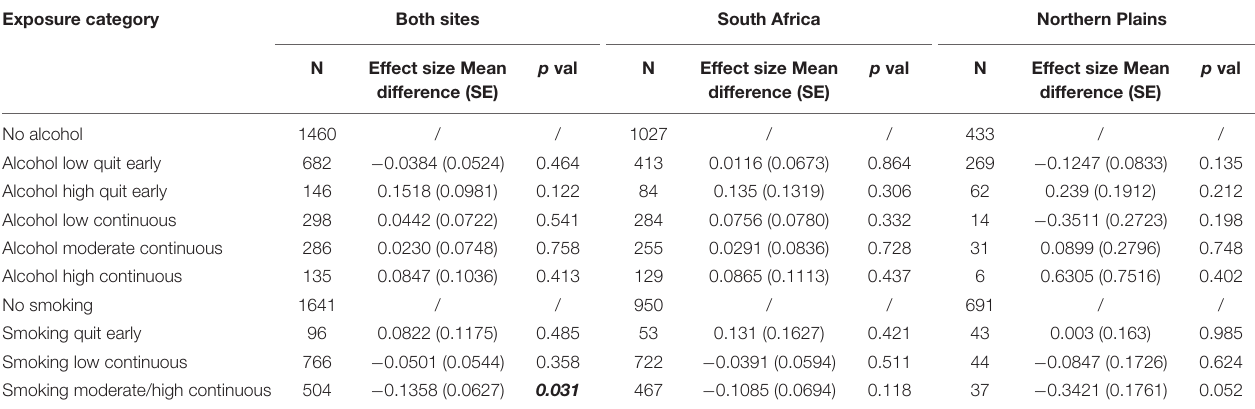
TABLE 9 | Linear regression results from alcohol and smoking exposure predicting mean fetal movement in